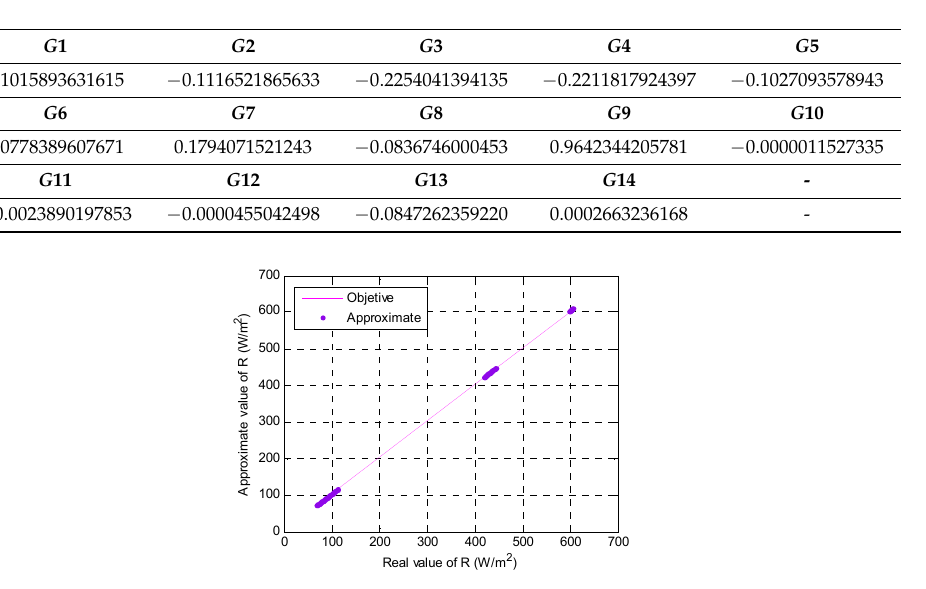
Figure 5. Correlation graph of Equation (4) applied to quasi-stationary measurements.